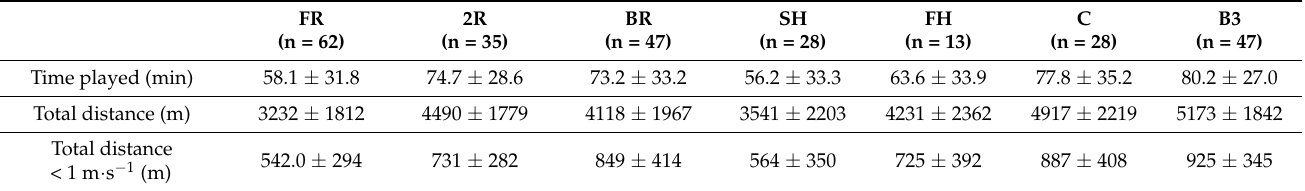
Table 2. Positional differences in the absolute physical match demands of match play for a squad of international female rugby union players during three consecutive years of the Women’s Six Nations